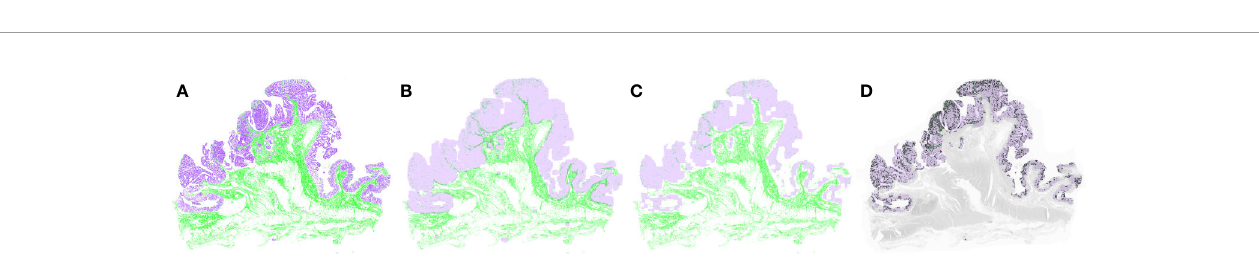
FIGURE 2 | Synthetic whole-slide images. (A) original pathology image. (B) Visualization of image segmentation by the model: colon cancer epithelium, purple; stroma, green; normal epithelium, light blue; muscle, orange; adipose tissue, red; lymphocyte, blue; mucus, yellow.